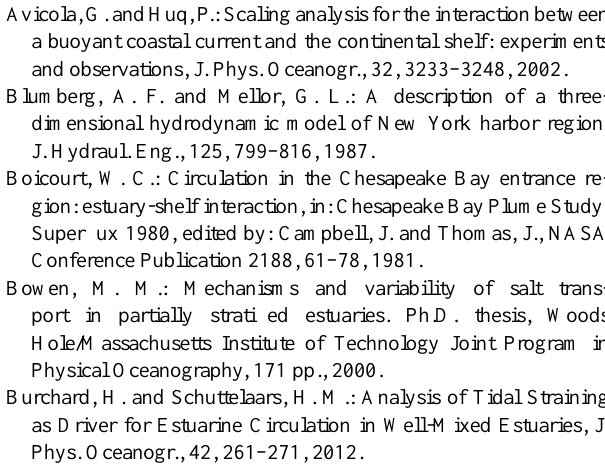
attained a maximum during the ebb phase throughout the wa- ter